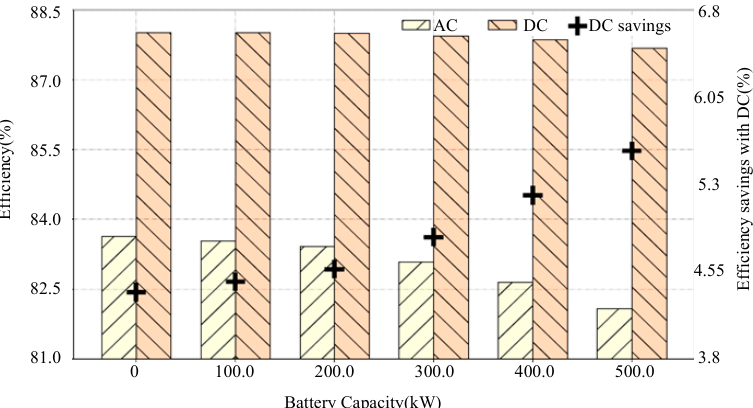
Figure 8. Efficiency trend with installed capacity of distributed PV.